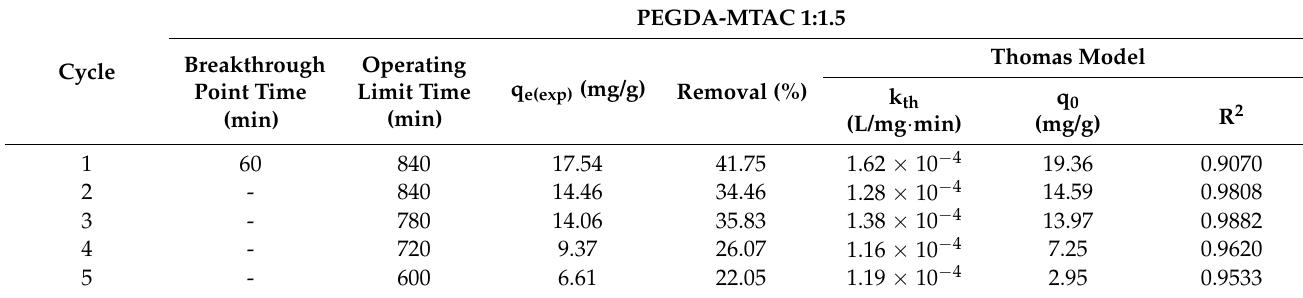
Table 9. Thomas model parameters linear regression analysis for